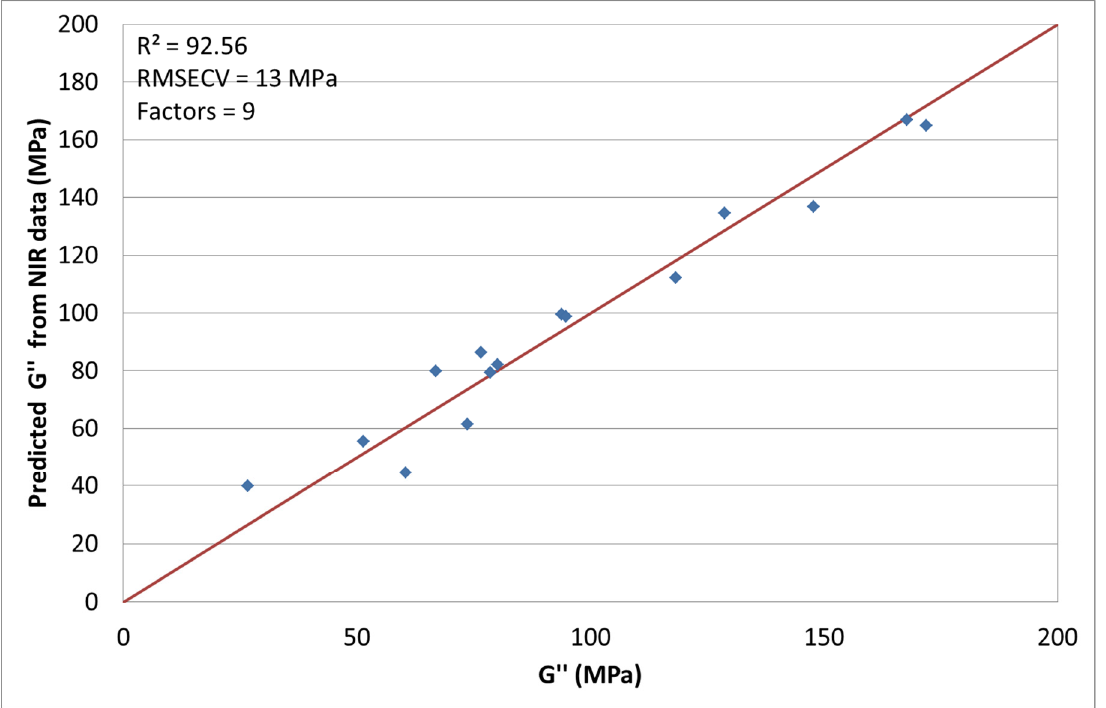
Figure 8. Predicted G ″ by NIR versus measured.